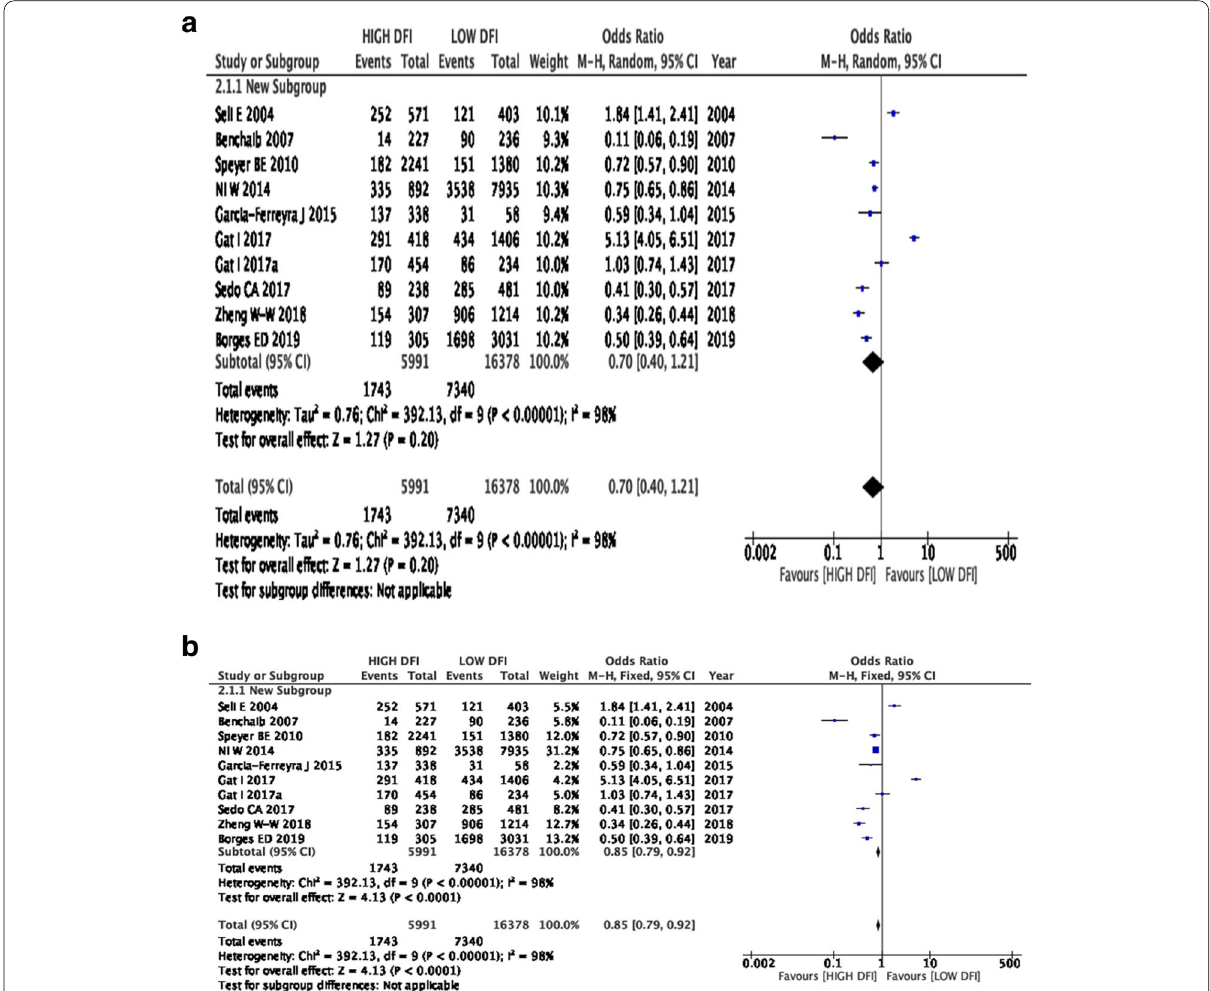
Fig. 2 Comparison of blastulation rate in high DFI and low DFI (random). b Comparison of blastulation rate in high DFI and low DFI